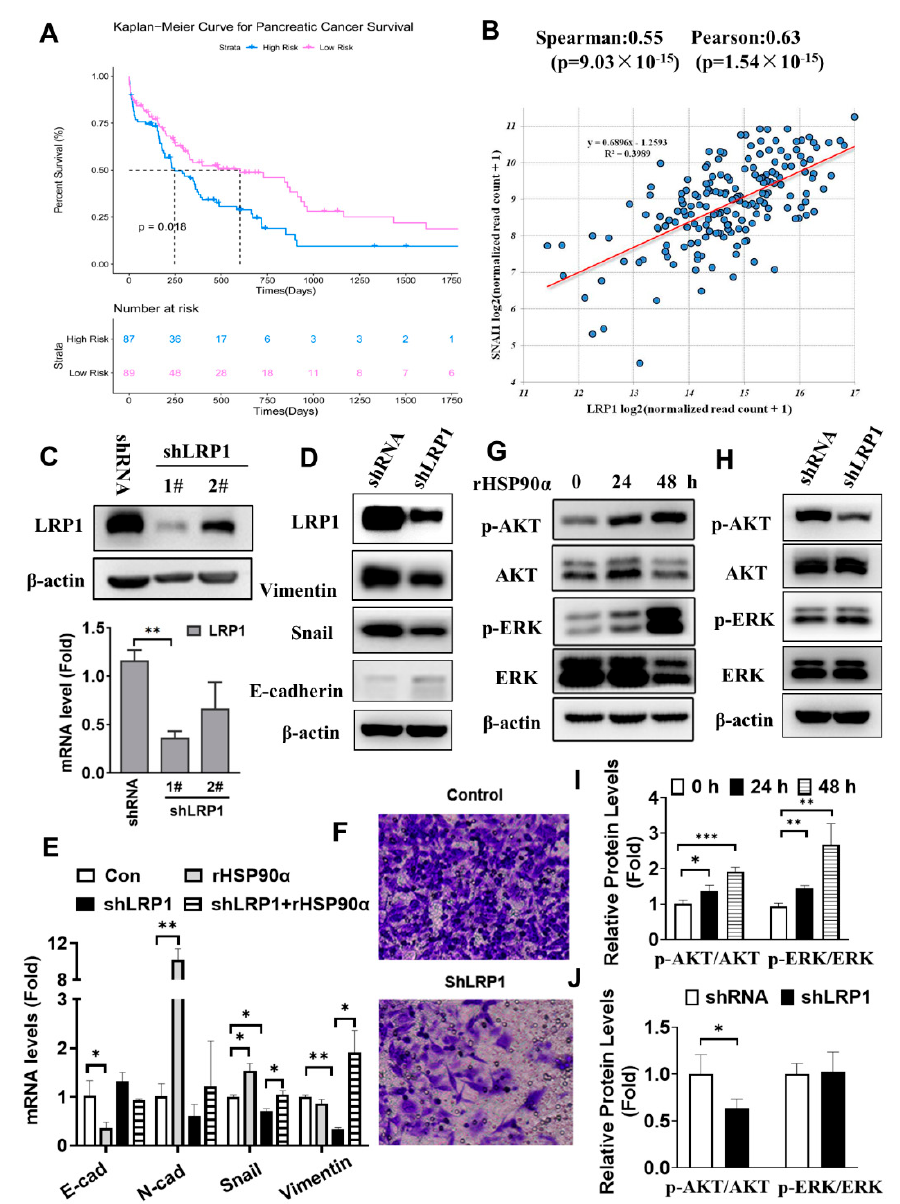
Figure 5. LRP1-medited AKT signaling is involved in secreted HSP90 α -induced metastasis and EMT events in PC cells. ( A ) Kaplan–Meier curves of overall survival probability for low (red line) and high (blue line) LRP1 expression in 176 PC patients, using TCGA databases (log-rank test, p < 0.05). ( B ) Correlation analysis between the LRP1 mRNA expression and the Snail mRNA level in data extracted from the TCGA databases. ( C ) The LRP1 mRNA and protein level after LRP1 knockdown by vector-mediated RNAi. ( D ) The LRP1, vimentin, Snail, and E-cadherin protein expressions in stably transfected shLRP1 Capan-2 cells. ( E ) The mRNA levels of E-cadherin, N-cadherin, Snail and vimentin after stably transfecting shLRP1 in Capan-2 cells or in the presence of rHSP90 α were detected by qRT-PCR. The data are expressed as the mean ± SD of the results from three separate experiments (* p < 0.05 and ** p < 0.01). ( F ) The invasion ability of Capan-2 cells after silencing LRP1 by Transwell assay. ( G , H ) The AKT and ERK signaling pathway activation in Capan-2 cells after rHSP90 α treatment or LRP1 knockdown were detected by Western blot analysis. ( I , J ) The relative protein levels are shown in the histogram. The data are expressed as the mean from three experiments. * p ≤ 0.05, ** p ≤ 0.01 and *** p ≤